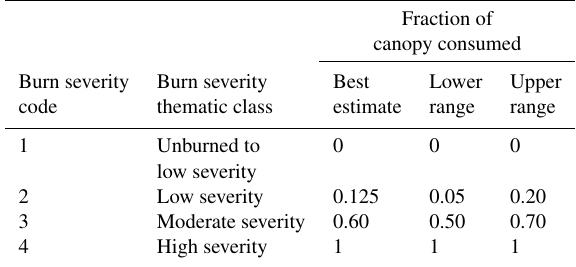
Table 7. Fraction of forest canopy consumed according to burn severity classification (after Miller and Yool, 2002).